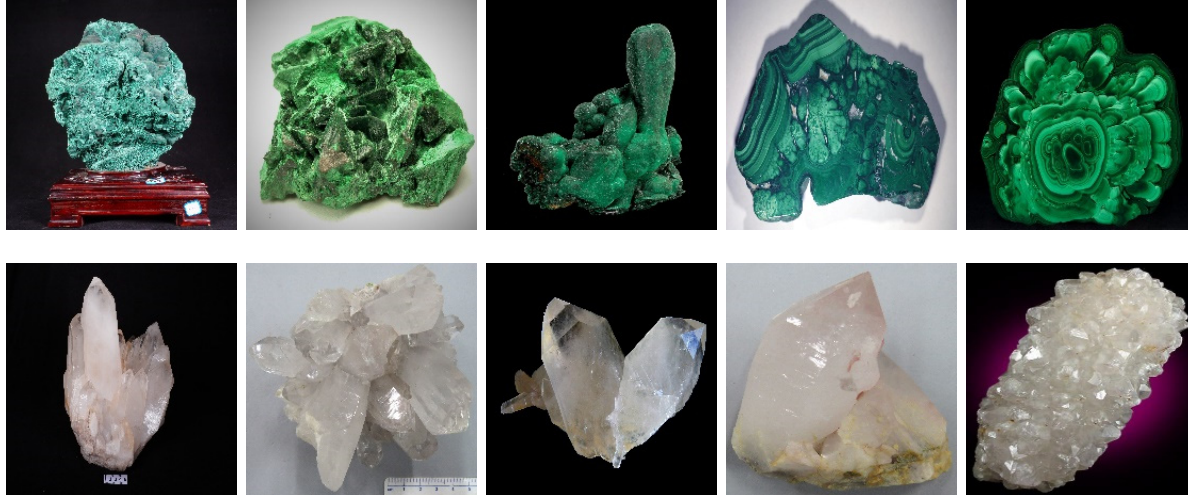
Figure 4. Samples of minerals with typical features. The first and the second row are malachite and quartz, respectively.